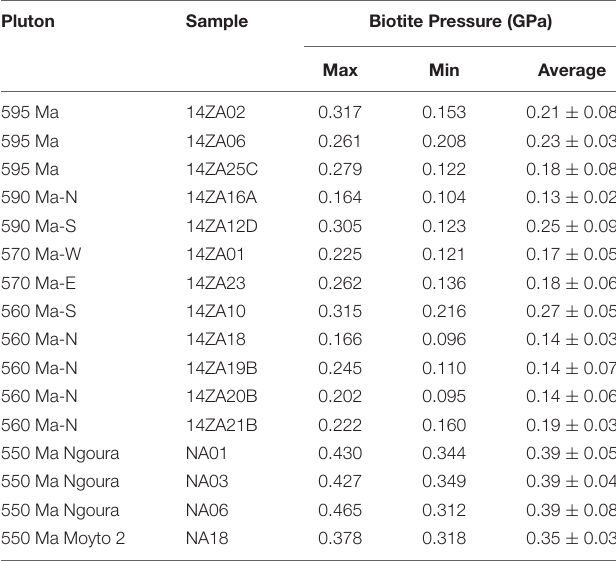
TABLE 2 | The range of amphibole pressure estimates from the Gueìra Massif granites. Pluton Sample